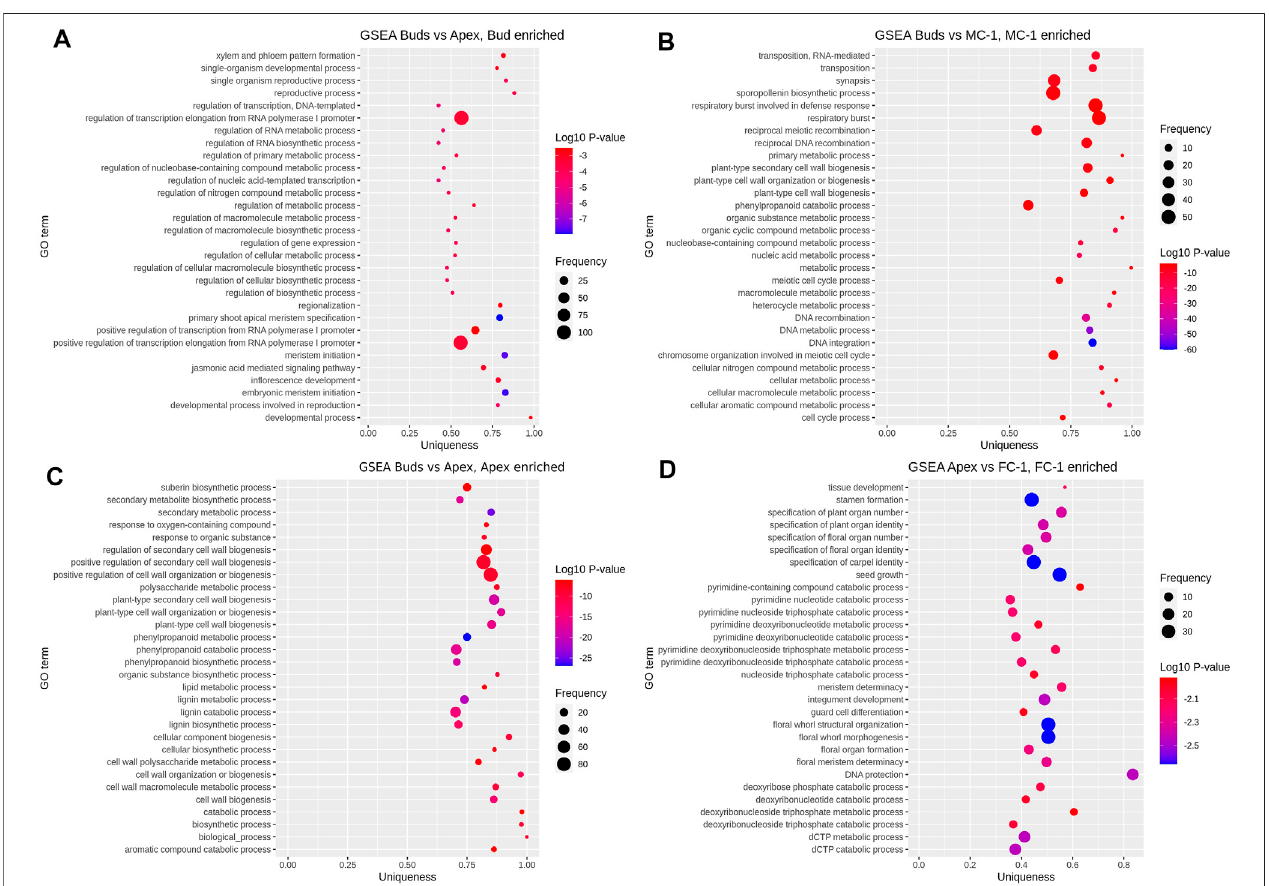
FIGURE 4 | Gene set enrichment analysis. Showing top 30 GO terms enriched in each set ofpairwise comparisons: (A) bud (enriched) vs. apex, (B) bud vs. MC-1 (enriched), (C) bud vs. apex (enriched), (D) apex vs. FC-1 (enriched). Vertical axis shows the GO terms and the horizontal axis represents the enrichment factor uniquenesswhichimplies whether thetermisanoutlierwhencomparedtotheentirelist.ColourchangerepresentstheLog10 p -valueandsizeofthebubble represents the number of genes in the GO term (frequency) which was obtained by comparing the number of enriched terms to the uniprot